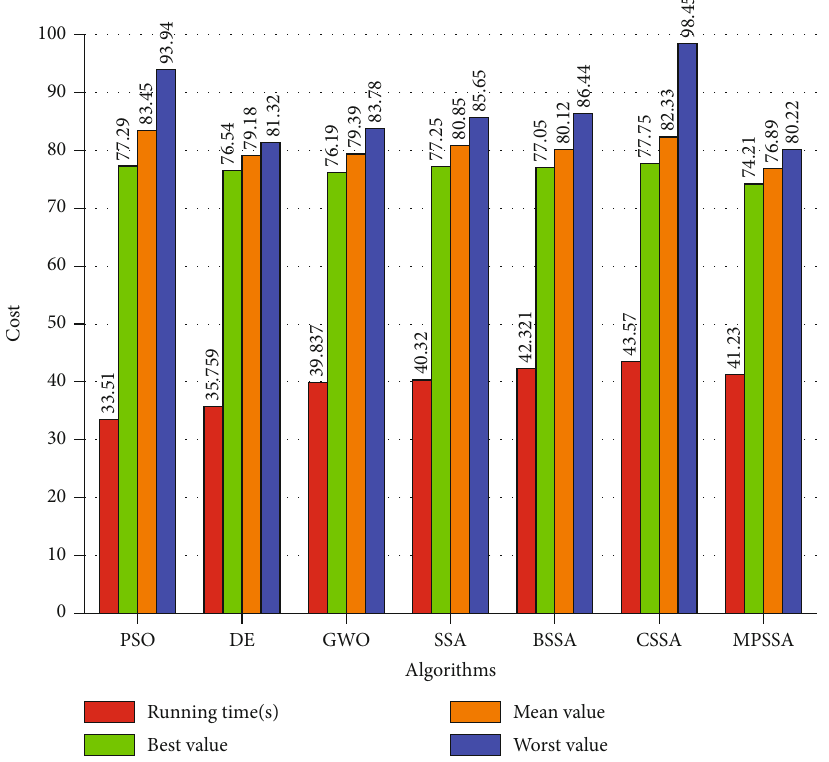
Figure 10: Single UAV planning results Table 6: Track planning for each UAV.